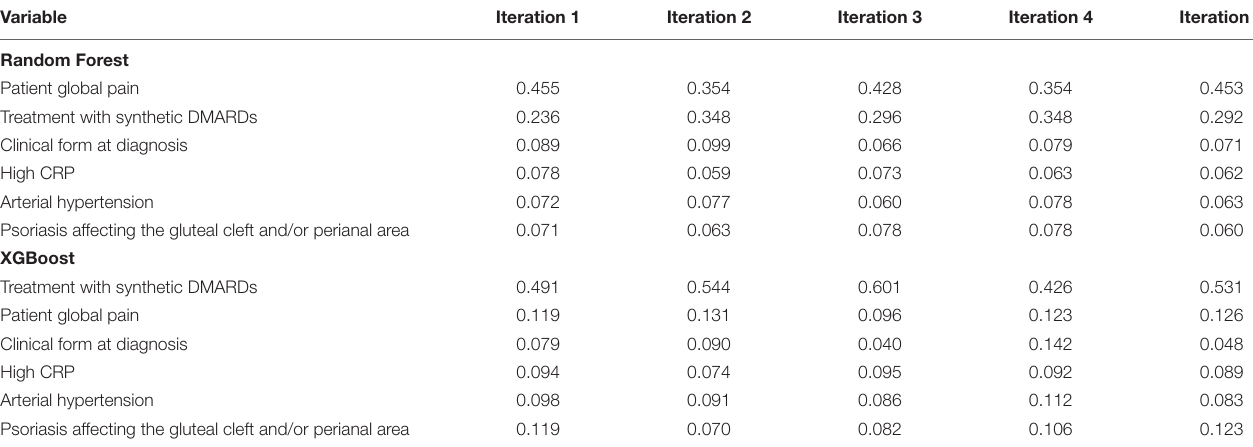
TABLE 4 | Feature importances of the variables in the different models trained in the cross validation.